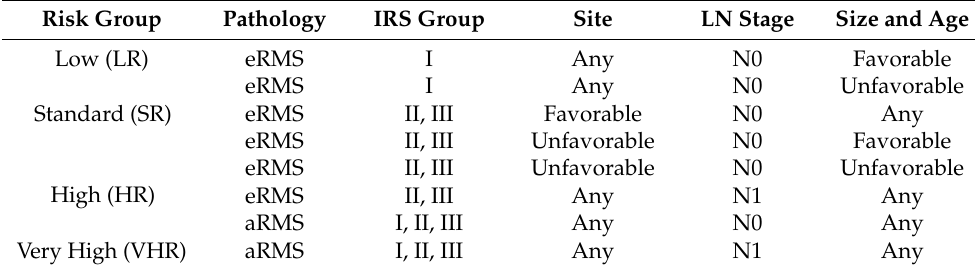
Table 1. Risk stratification for patients with localized